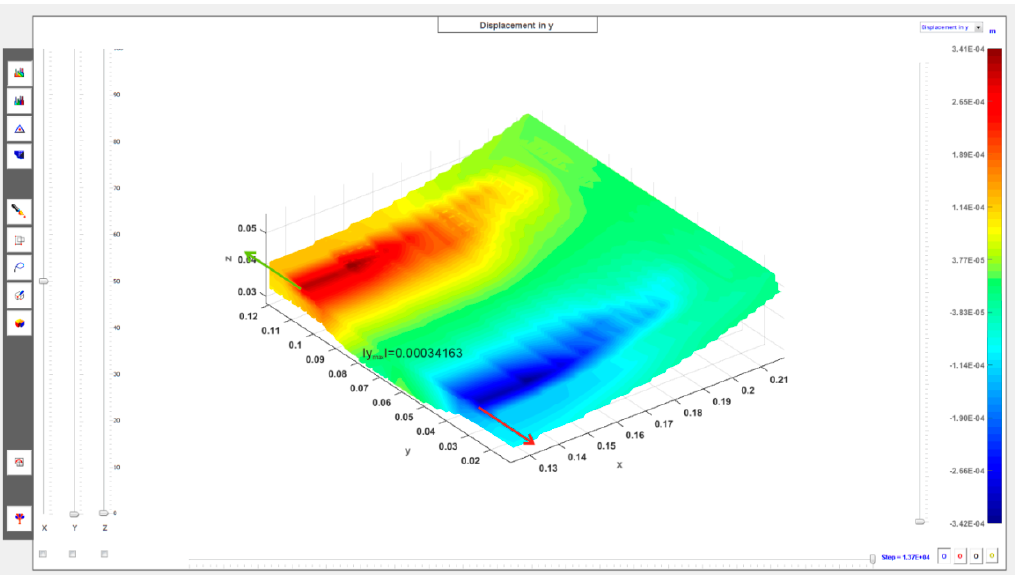
Figure 11. Displacements (in meters, middle section) in sand layer in parallel y direction to roller axis: h = 5 mm, p opt = 3.6 bar ( N = 1800 N).